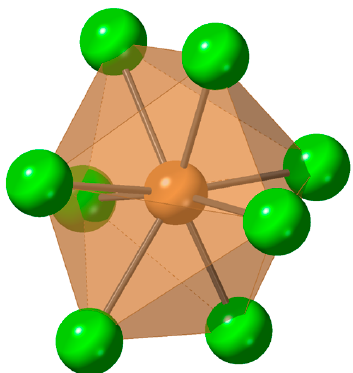
Figure 2. Bisdisphenoidal coordination of Ca in verneite. Projection based on crystal structure data from Reference [13]. Table 3. The coordination parameters of [CaF n ] coordination polyhedra in fluoride minerals and related synthetic compounds; υ = volume distortion; O. = Octahedron; P.b. = Pentagonal bipyramid; S.o. = Split octahedron; Bis. = Bisdisphenoid; S.a. = Square antiprism; C. = Cube; T.t.p. = Tricapped trigonal prism; T.c. = Tricapped cube.